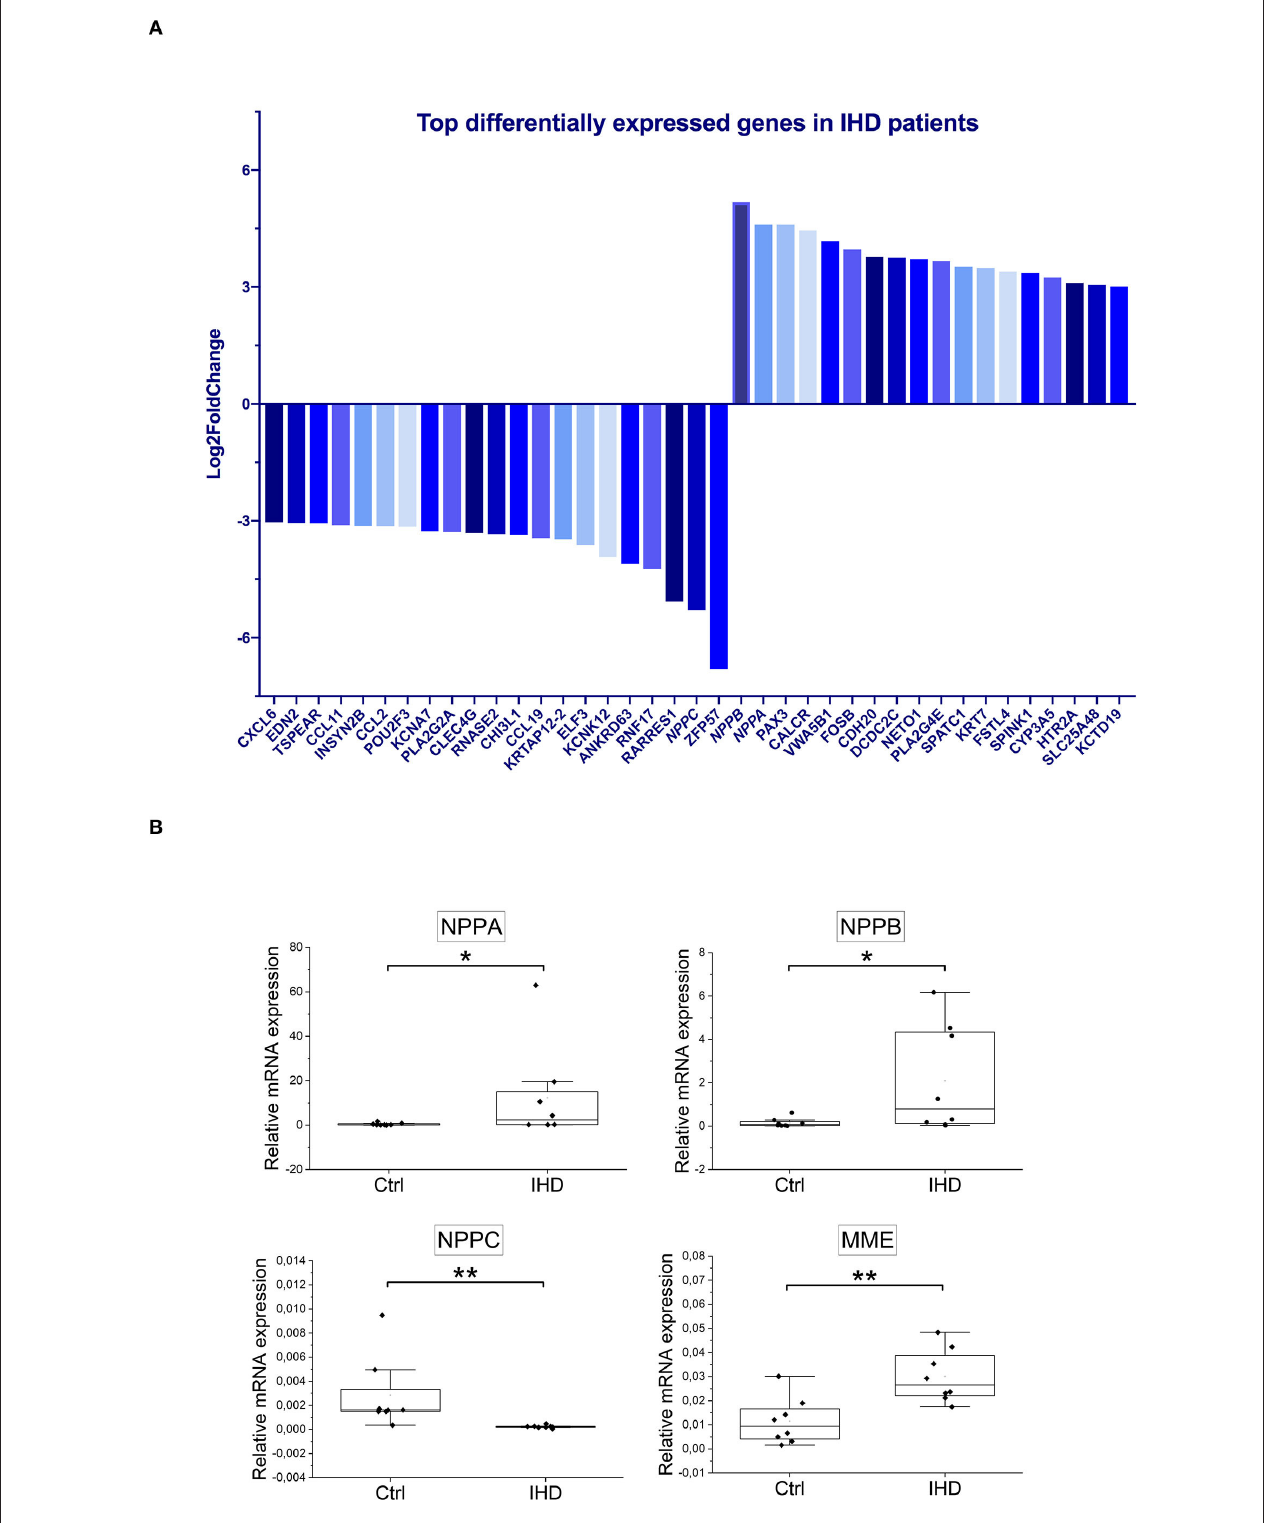
FIGURE 4 | Top differentially expressed genes in IHD patients. (A) The significantly altered genes were ranked based on Log2FoldChange (IHD n = 8, Ctrl n = 7). Only the ones with values ≥ ± 3 were displayed. (B) Tissue RT-qPCR validation (IHD n = 8, Ctrl n = 8) for NPPA , NPPB , NPPC , and MME genes. ACTB ( β -actin) was taken as an internal control. Statistical analysis was made by Mann-Whitney U Test. P < 0.05 was considered as statistically significant. n.s. not significant, * p < 0.05, ** p < 0.01.